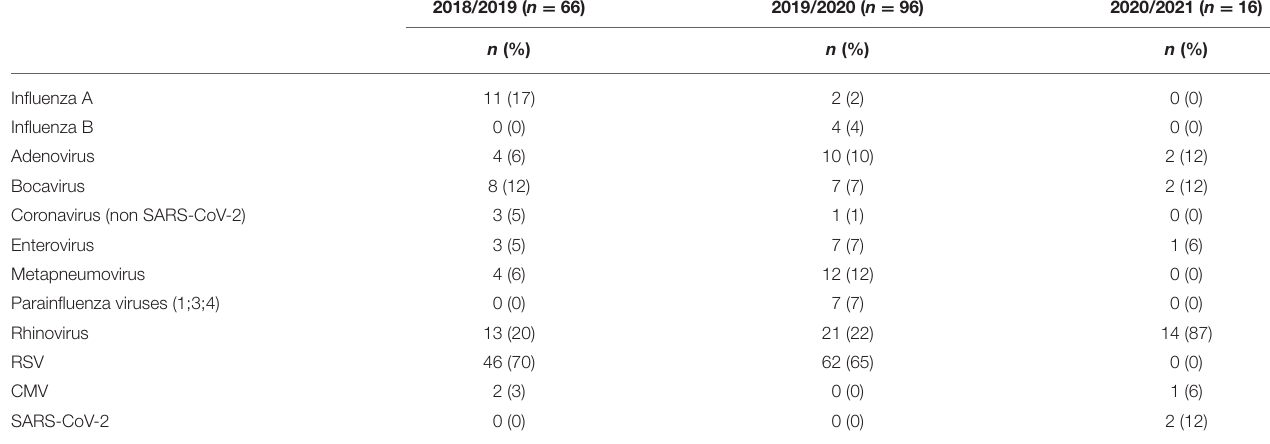
TABLE 2 | Viral detections by